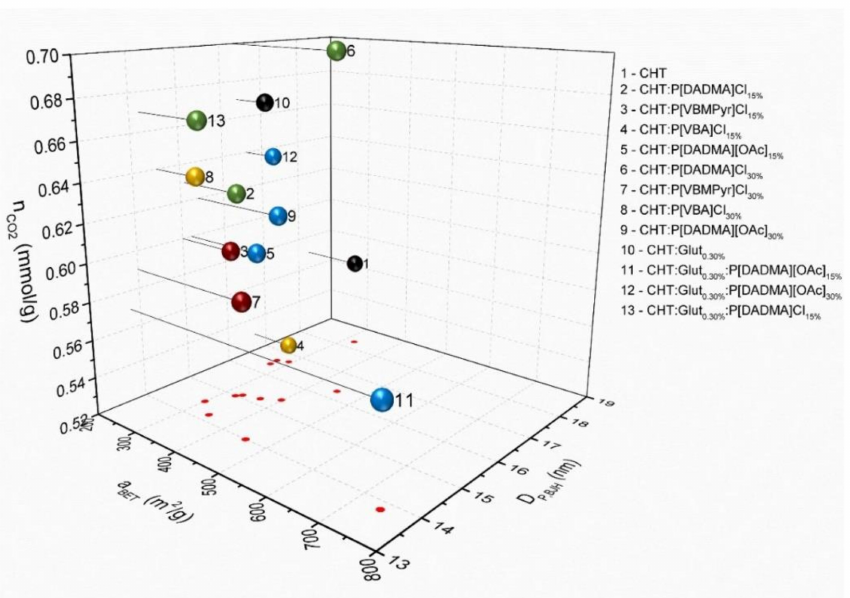
Figure 6. Correlation between CO 2 capture capacities of AEROPILs , specific surface area and mean pore diameter. Notation: n CO2 , CO 2 capture capacity; D P,BJH , mean pore diameter; a BET , specific surface area. Chitosan aerogels without PIL (black); P[DADMA]Cl AEROPILs (green); P[VBMPyr]Cl AEROPILs (red); P[VBA]Cl AEROPILs (yellow); P[DADMA][OAc] AEROPILs